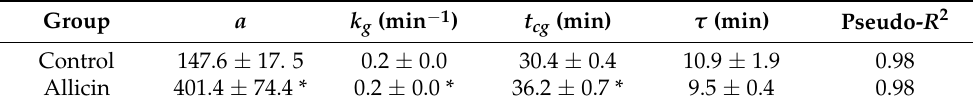
Table 2. Model discrimination results for the logistic-exponential kinetic model in Glc/Asn solution